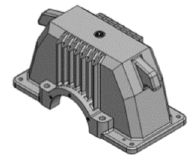
Figure 10. Upper casing.